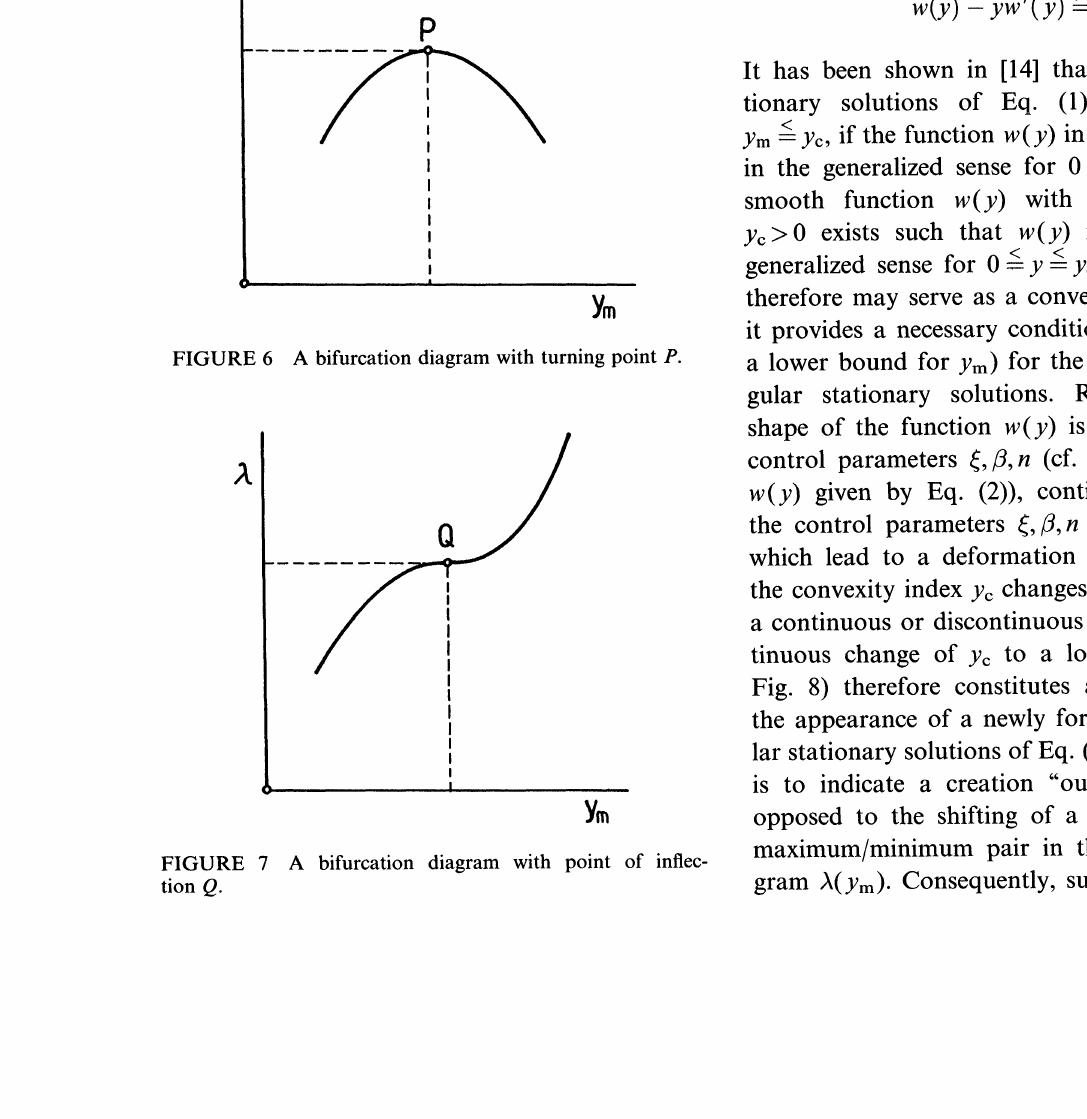
FIGURE 5 A butterfly singularity Q+ with a selection of contours displaying the creation of a cusp triplet (dashed lines).